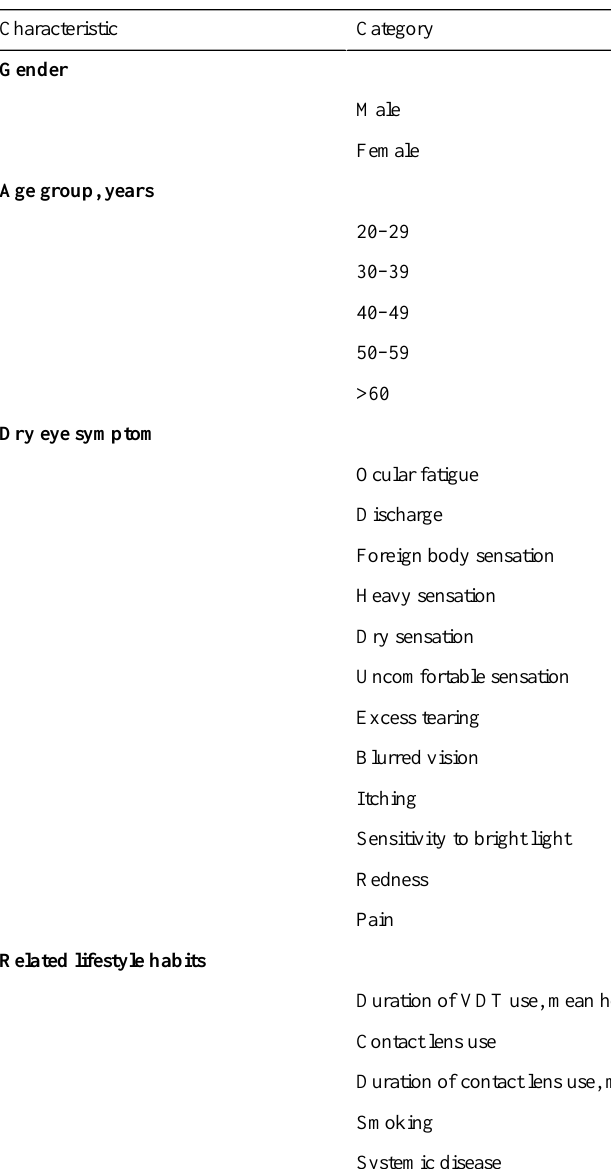
Table 3. Characteristics of the 99 second-phase